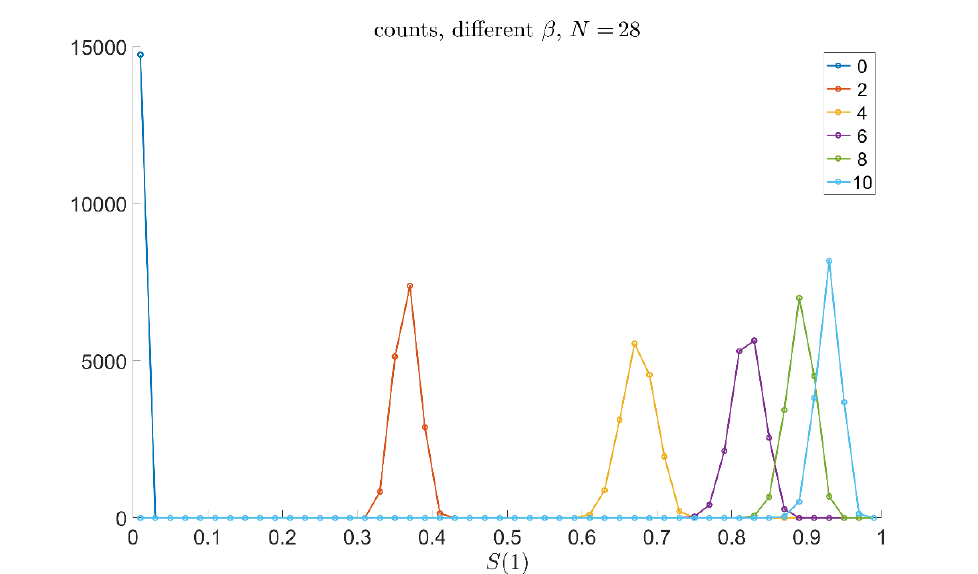
Figure 19 . Histogram of the entropy of one pair of Majoranas for N = 28 Majorana fermions in a single SYK cluster ( L = 1). The di(cid:11)erent curves correspond to (cid:12) = 0 ; (cid:1) (cid:1) (cid:1) ; 10 in units with J 0 = 1. As (cid:12) varies, the entropy increases from zero and remains reasonably peaked. As the average approaches one, the distribution appears to become more peaked, possibly indicating convergence to a value independent of s at large (cid:12) and large N .